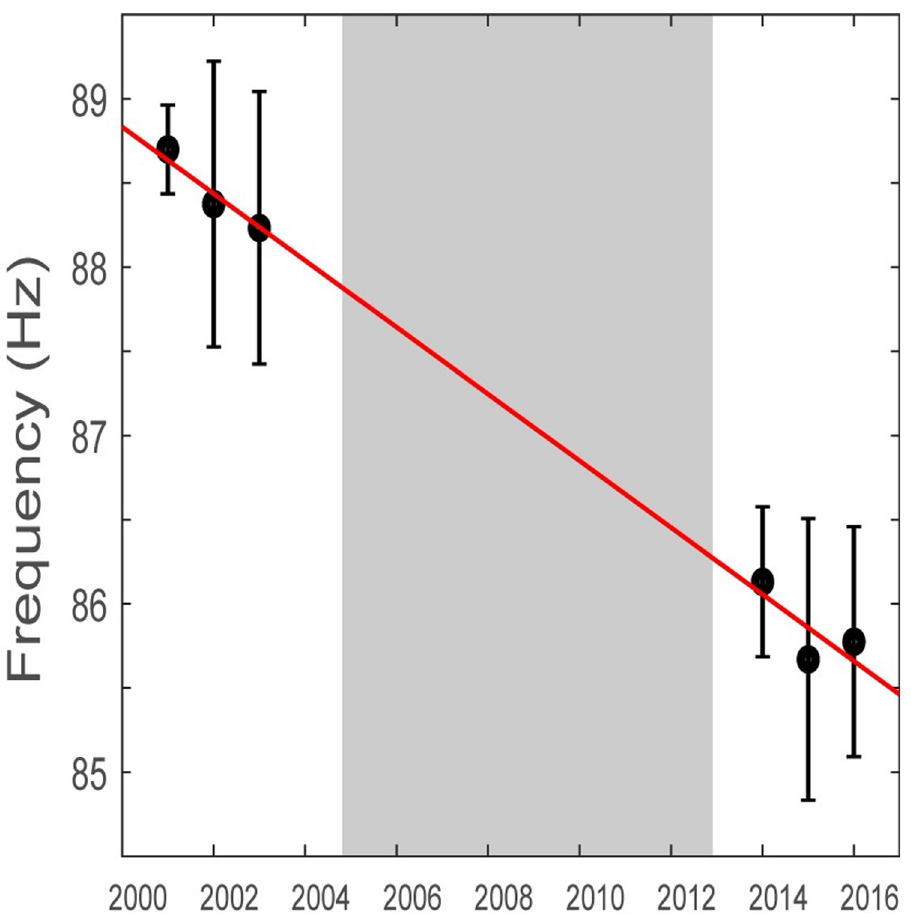
Fig 4. Annual mean overtone frequency. Mean overtone frequency (circles; in Hertz) and standard deviation (bars) of fin whale pulses for each year analyzed. Red line represents linear trend. Gray-shaded area indicates a break in recording